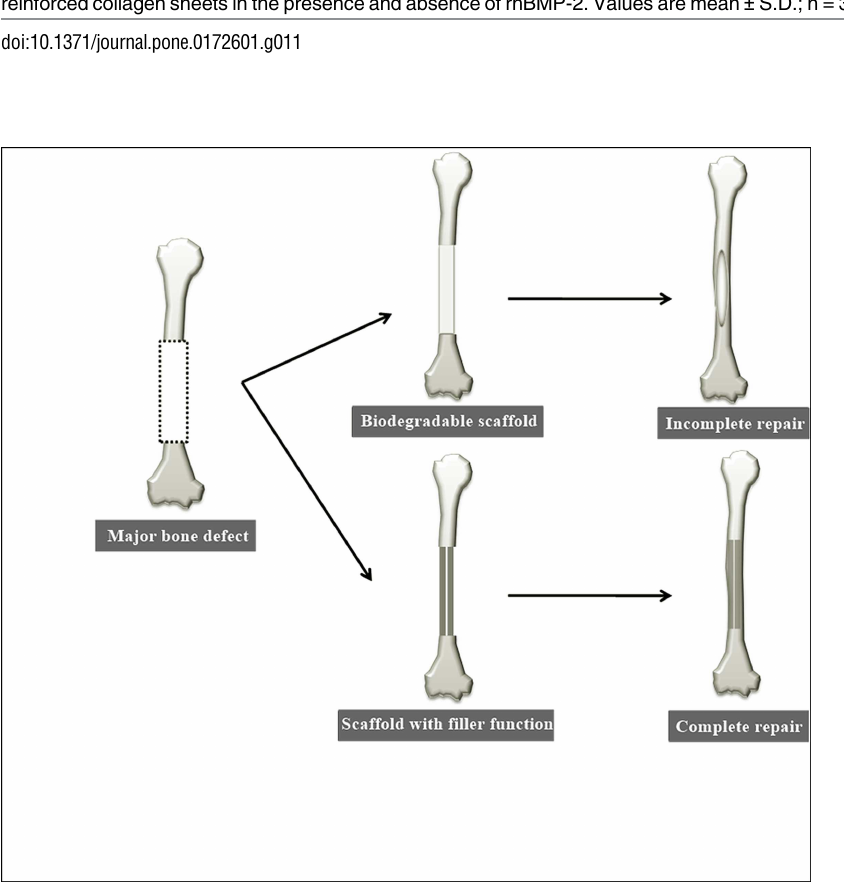
Fig 12. Scheme for bone regeneration treatment using a biodegradable scaffold and a scaffold that also servesas a filling material. There is a need for a non-biodegradablescaffold with the high osteoinductive potentialof BMP and capacity to fill the gaps left by bone